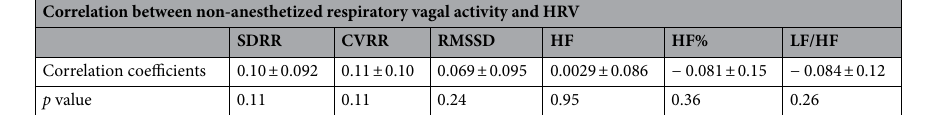
Table 4. Correlations of non-anesthetized respiratory vagal difference with HRV. Data shown are the averages for four animals (358 total recordings). None of the six HRV metrics have correlations significantly different from zero (Bonferroni corrected significant level of p = 0.0083). Supplemental Table 4 shows individual correlations and p values for each animal.